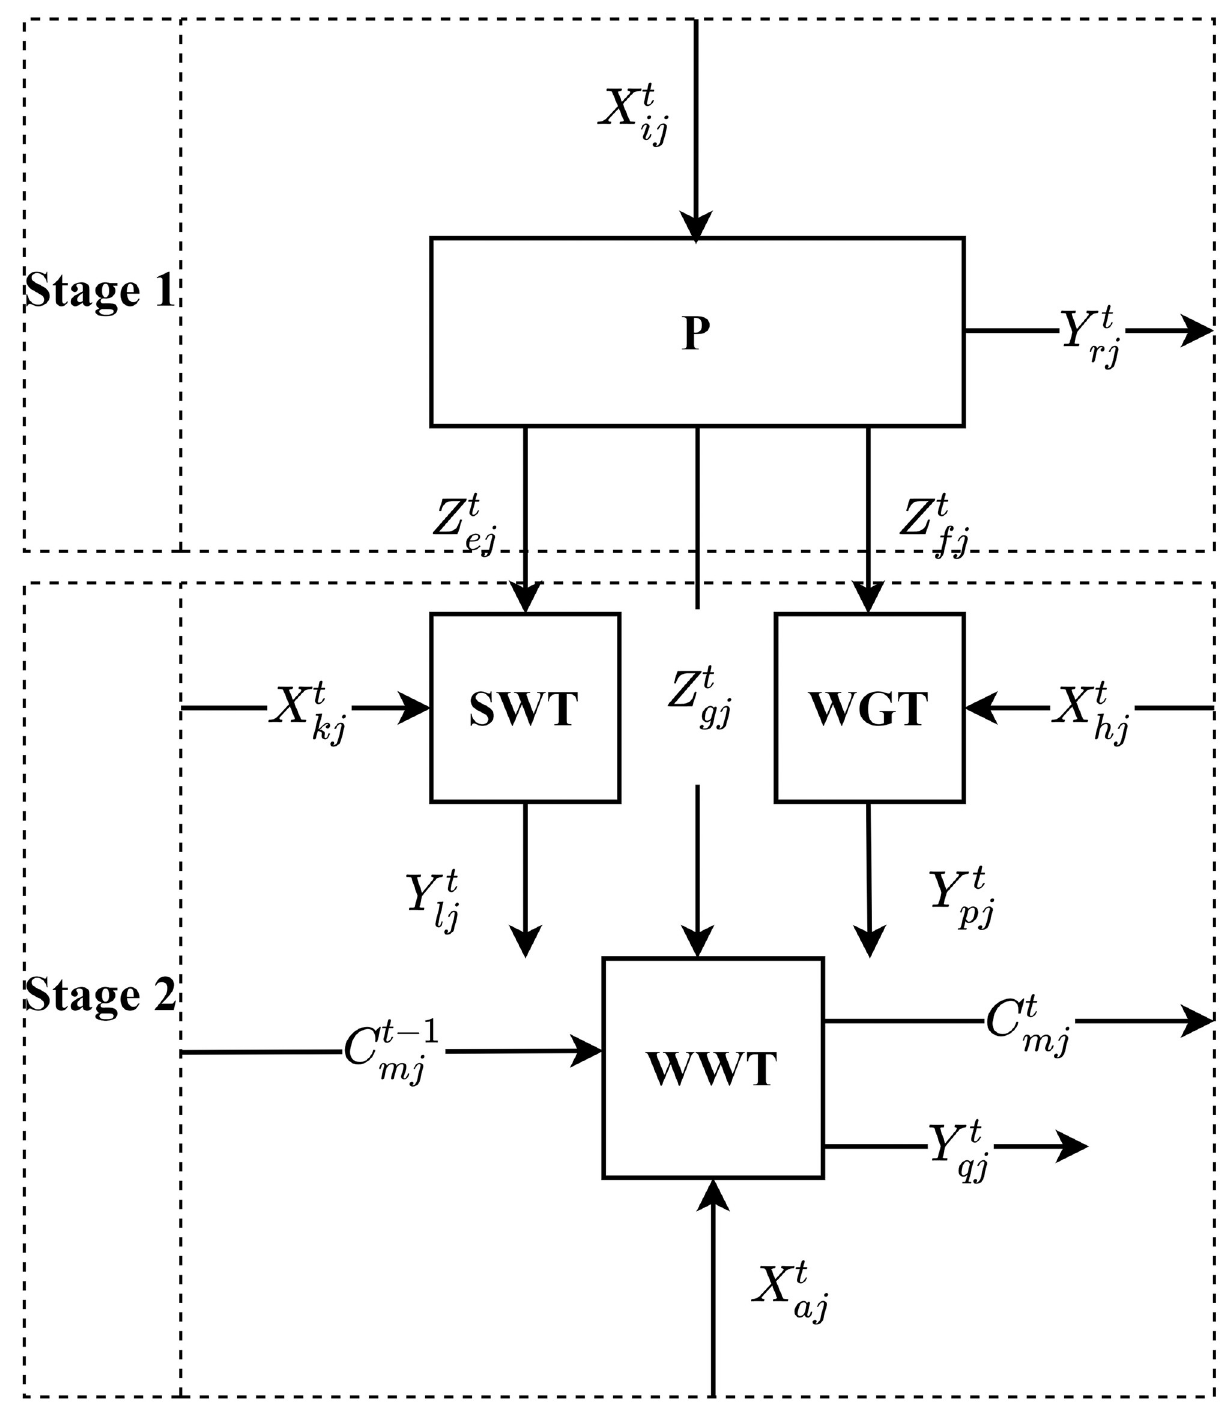
Fig 2. Structure of Chinese industrial system in a specific period t.